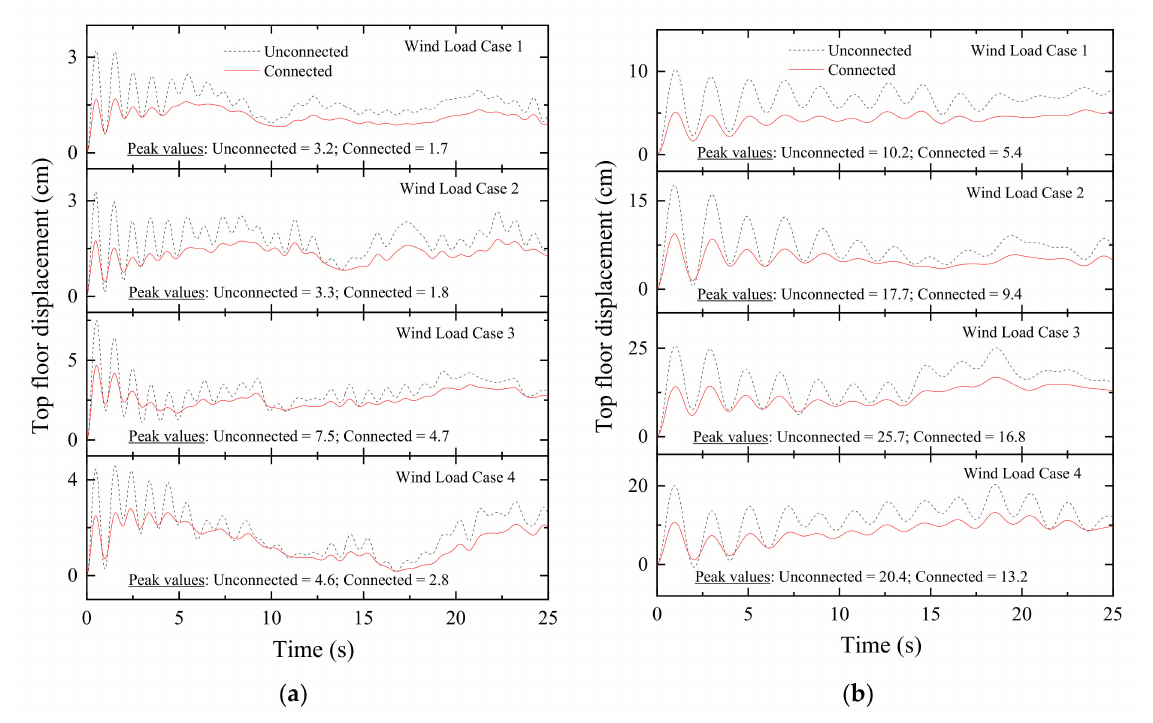
Figure 26. Time history of top floor displacement under wind excitation in: ( a ) a coupled stiff building and ( b ) a coupled flexible building when semi-active MR dampers are used as coupling devices in Configuration 1.